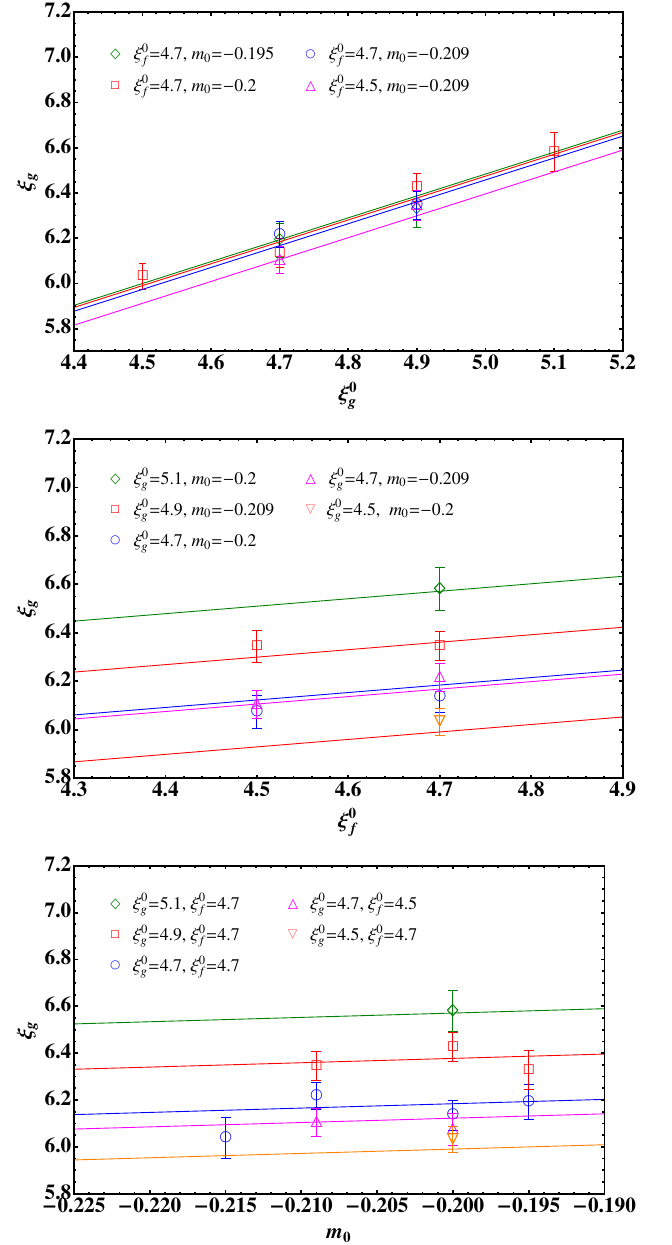
Figure 12 . Gauge anisotropy (cid:24) g as a function of (cid:24) 0 functions in eq. (3.7) where the coe(cid:14)cients are given by eq. (3.13).